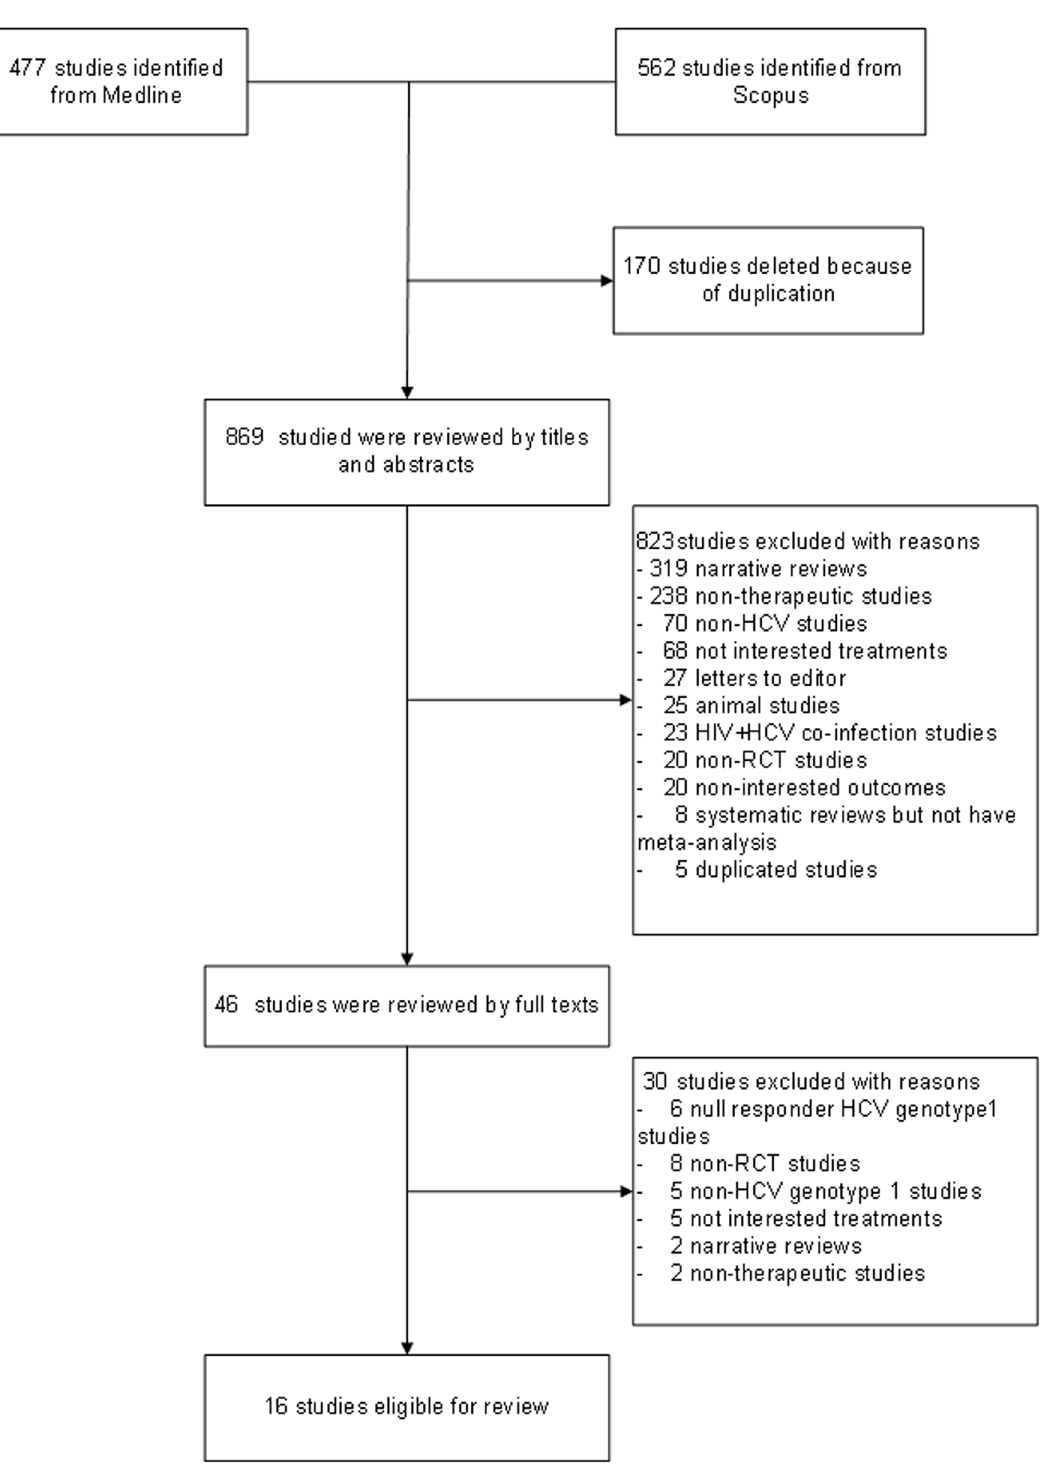
Fig 1. Flow chart of study selection.